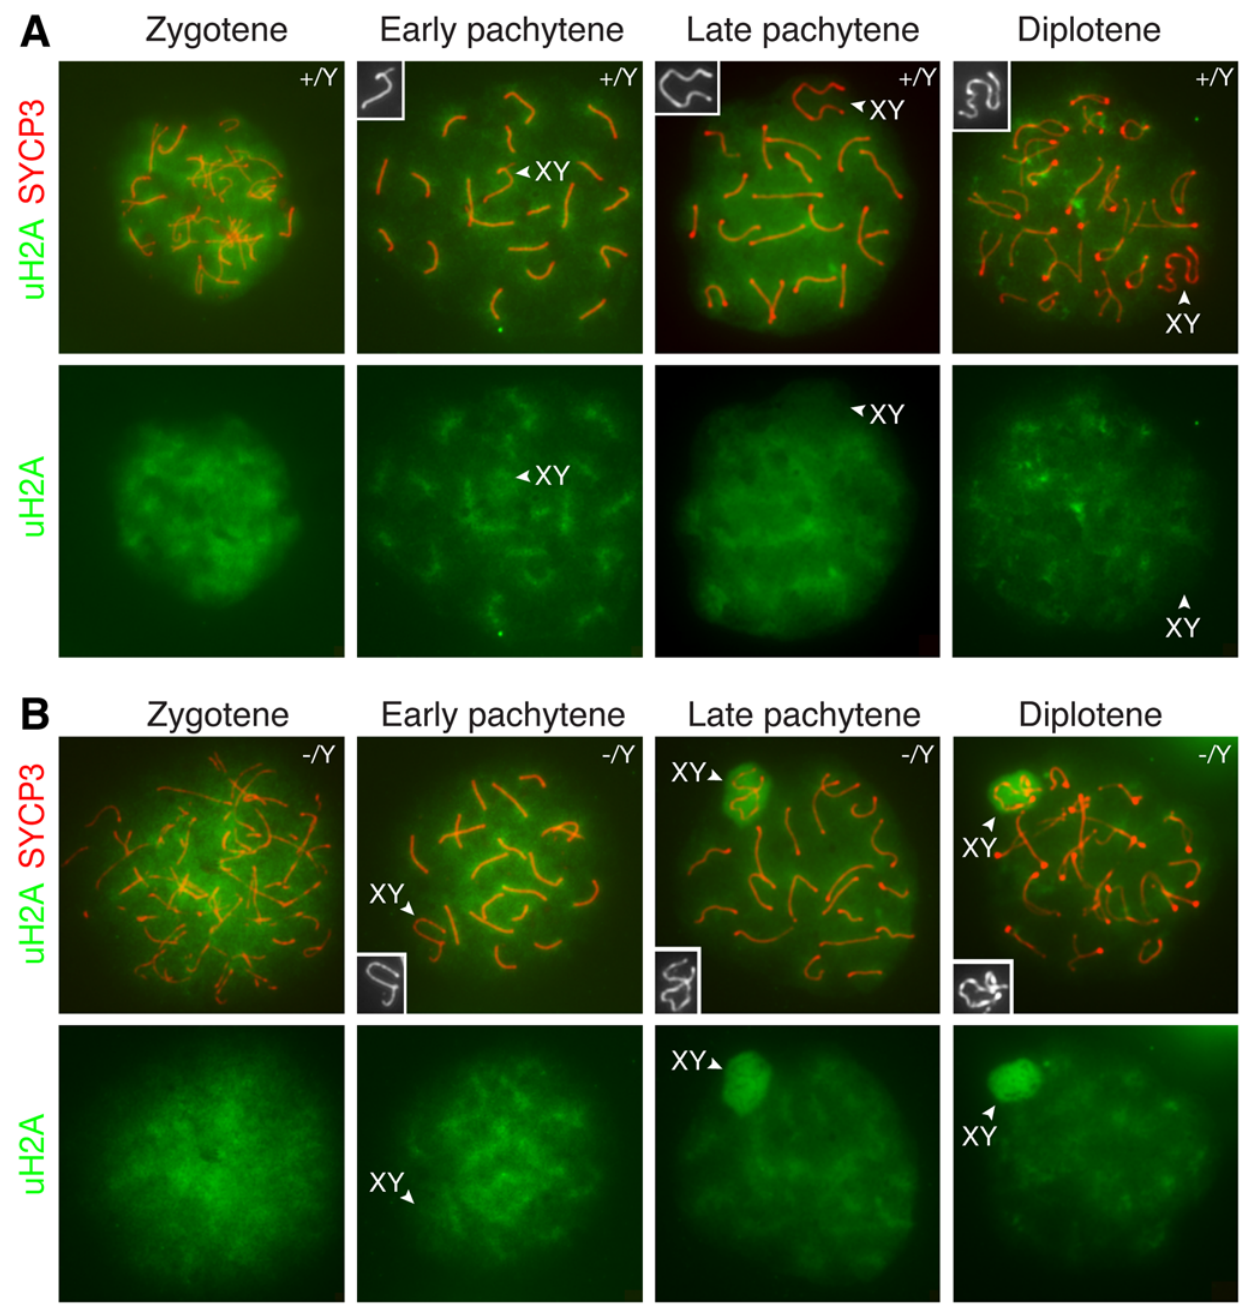
Figure 5. Increased H2A monoubiquitination in the XY body in Scml2 -deficeint pachytene and diplotene spermatocytes. Distribution of monoubiquitinated H2A (uH2A) in wild type (A) and Scml2 -/Y (B) prophase I spermatocytes were examined by immunostaining of spread nuclei with anti-SYCP3 (red) and anti-uH2A (green) antibodies. uH2A staining alone is shown in the bottom panels. The XY bodies are indicated by arrowheads and shown in the insets. Notably, uH2A localizes to and radiates from the synaptonemal complexes in wild type and Scml2 -/Y pachytene